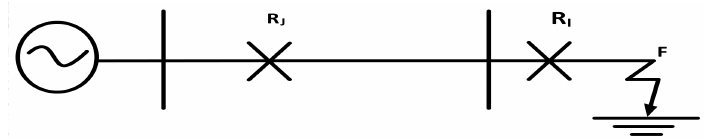
Figure 1. A single end radial distribution